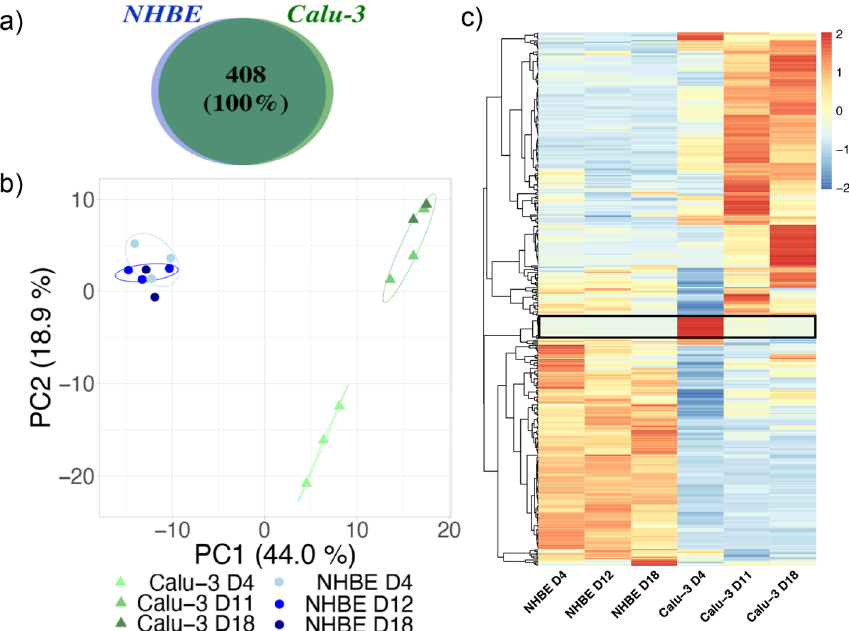
Figure 3. Proteomic analysis of the apical secretome of the human bronchial epithelium in Calu-3 and NHBE models. ( a ) Qualitative analysis of the extracellular proteins of Calu-3 and NHBE cells at day 4, day 11 (Calu-3) or 12 (NHBE), and day 18 after ALI. The total number of proteins and the percentage of common proteins are shown in a Venn diagram. ( b ) Comparison of the abundance of extracellular proteins by Principal Component Analysis (PCA). The analysis was performed at day 4, day 11 (Calu-3) or 12 (NHBE), and day 18. The different donors (NHBE cells) and biological replicates (Calu-3 cells) are represented for each condition and circled on the graph. The percentage associated with each principal component is indicated in the axis legend. ( c ) Heat map of extracellular proteins identified in the apical secretome of Calu-3 cells and NHBE cells at day 4, 11–12, and 18 after ALI. A protein set showing a large difference at day 4 in the secretome of Calu-3 cells is highlighted by a black